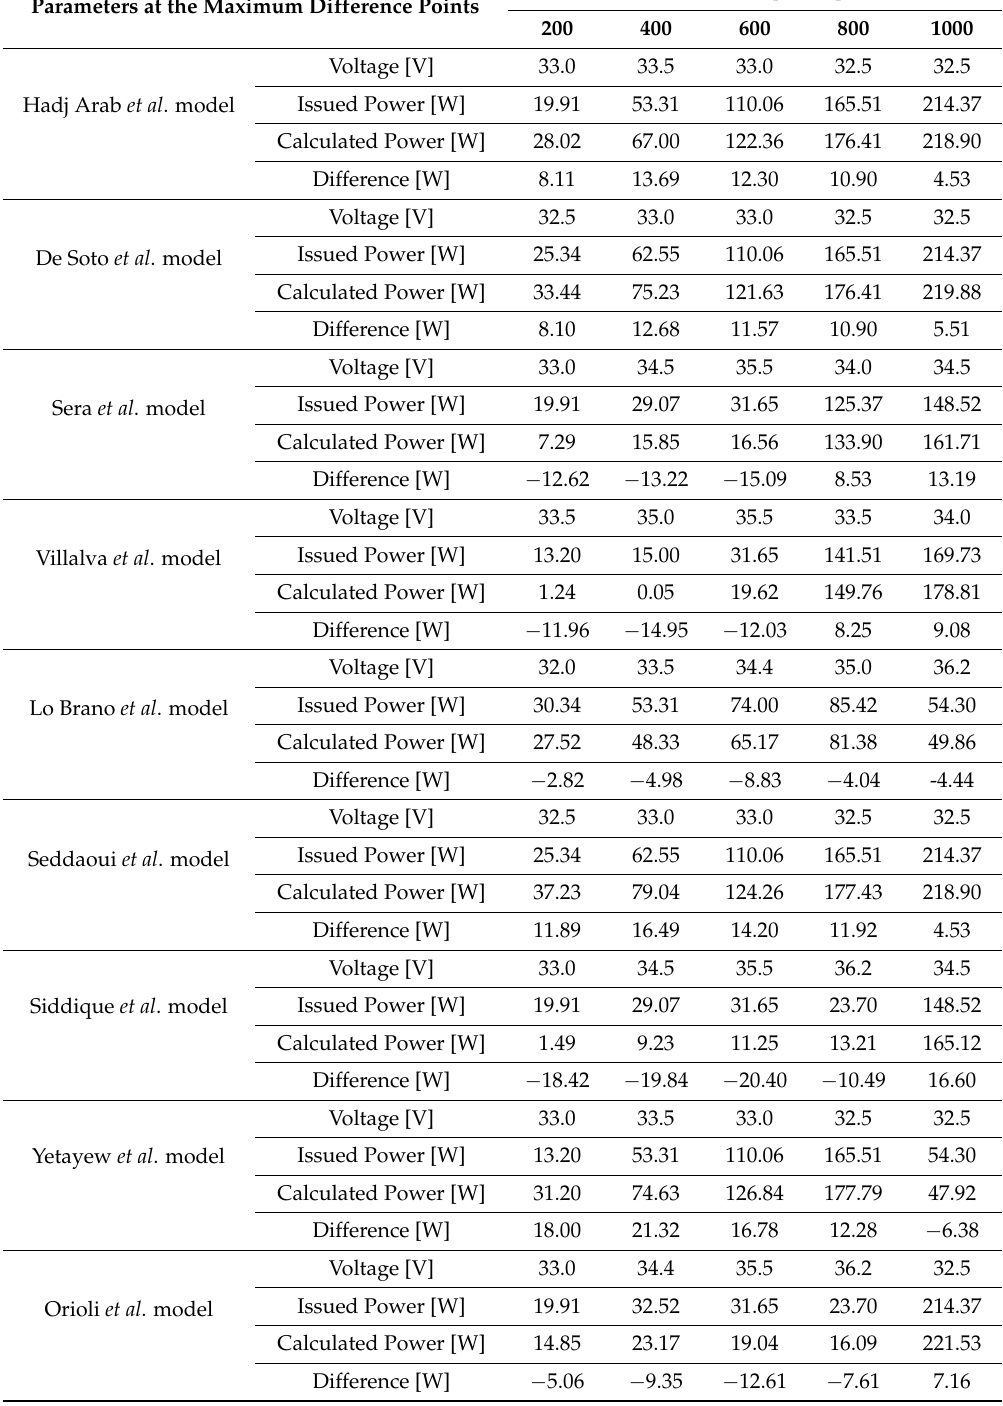
Table 11. Maximum power differences between the calculated and the issued I-V characteristics of Kyocera KD245GH-4FB2, at temperature T = 25 ˝